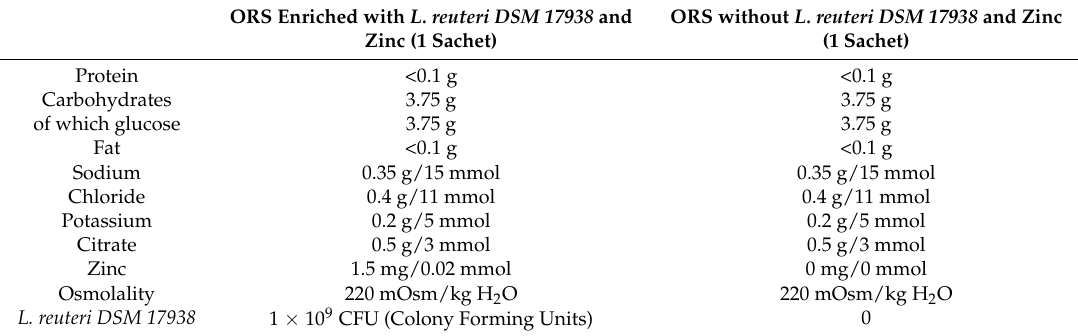
Table 1. Composition of the study products.